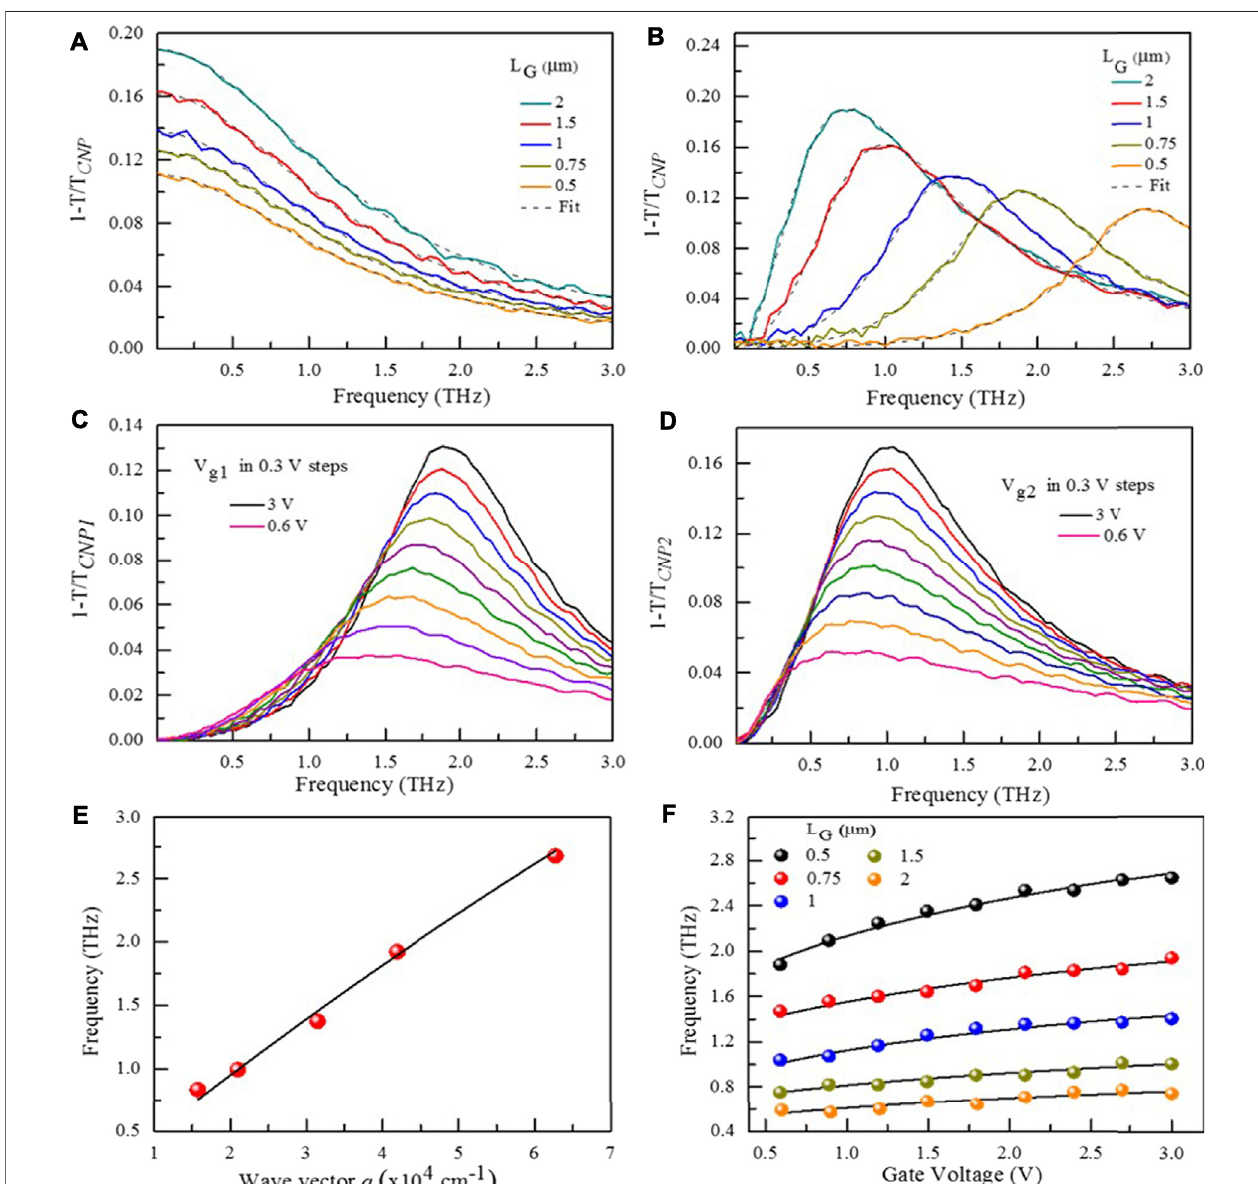
FIGURE 2 | Gate voltage – and length-dependent extinction spectra of the graphene structures for V d (cid:1) 0 V. Plasmonic cavity length (L G ) – dependent extinction spectra of the three devices with incident light polarized parallel (A) and perpendicular (B) to the DGG fi ngers. The measured line shape is well reproduced by a Drude model fi t for parallel polarization [dashed line in (A) ] and a damped oscillator model fi t for perpendicular polarization [dashed line in (B) ]. Measured gate voltage – dependent transmission spectra 1 − T / T CNP of the asymmetric device A-DGG1 with incident light polarized perpendicular to the DGG fi ngers, with biased cavities C1 when sweeping V g1 , while the voltage on the other gate electrode is kept constant at V g2 (cid:1) V CNP2 (C) and biased cavities C2 when sweeping V g2 , while the voltageontheothergateelectrodeiskeptconstantat Vg1 (cid:1) V CNP1 (D) .Scalinglawsofgrapheneplasmonresonancefrequencyinthethreedevicesasafunctionofwave vector q (cid:1) π / L G (E) and gate voltage (F) . The solid lines in (E) and (F) are fi ts to data using the model expressed in Eq. 1 . After Ref. 46.